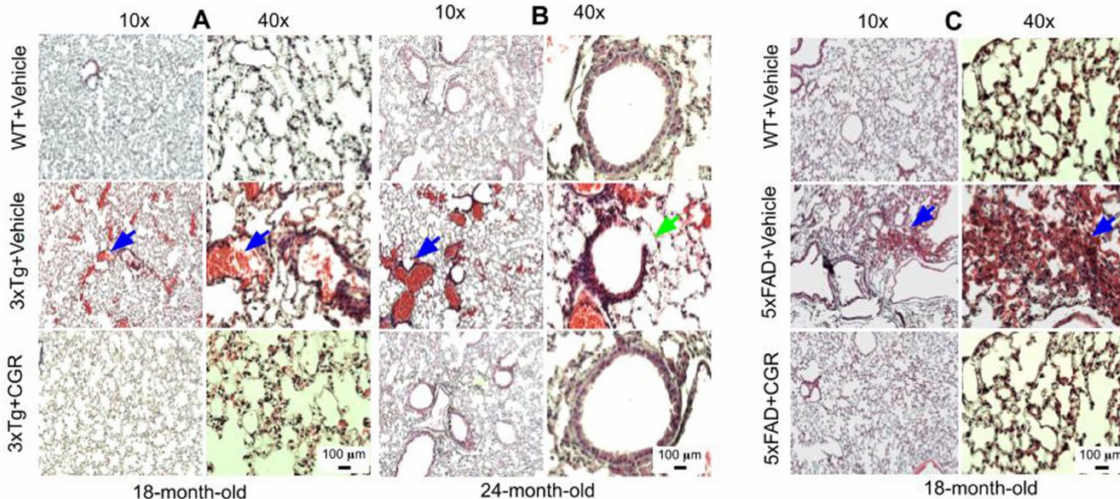
Figure 7. Lung morphology was improved by CGR treatment in both 3xTg and 5xFAD mice. Wild-type, 3xTg, and 5xFAD mice were treated with CGR (100 mg/kg) for 2 months and the mice were perfused with PBS and fixed with 4% paraformaldehyde and the lungs were dissected out, embedded with paraffin, sectioned at 5 µ m and stained with hematoxylin and eosin (H&E) and the images were taken with a compound light microscope, using either 10- or 40- × objectives (total magnification = 100 × or 400 × ). ( A – C ) Representative images of lung tissue from 18-month-old ( A ), 24-month-old ( B ) 3xTg mice and 18-month-old 5xFAD mice ( C ) after treatment with CGR. Significant damage of lung morphology, including blood infiltrations (blue arrows) and bronchial damage (green arrow), were observed in the lung tissue of both 3xTg and 5xFAD mice with treatments of CGR preventing these abnormalities. Scale bar = 50 µ m and is applicable to all other